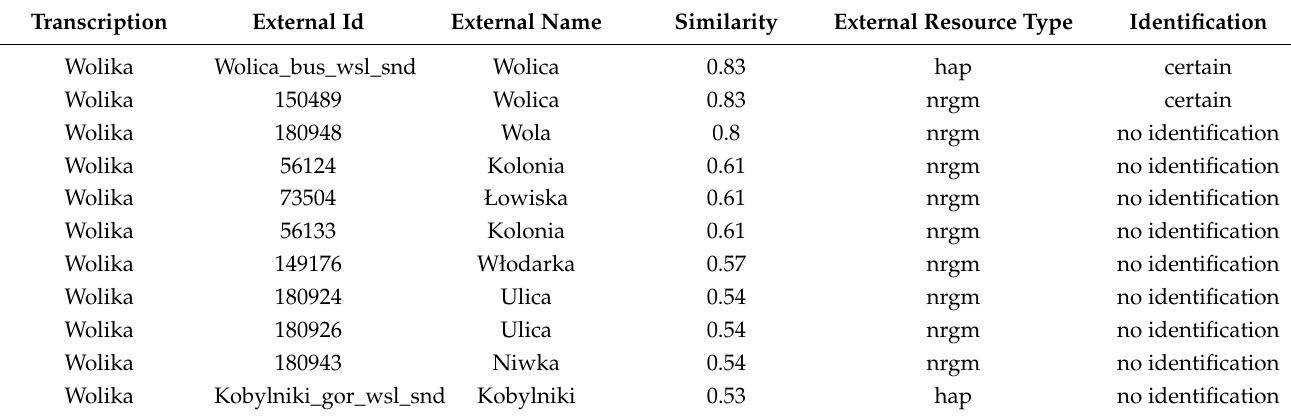
Table 2. Fragment of the table containing place names from ‘special maps’ and matched place names from